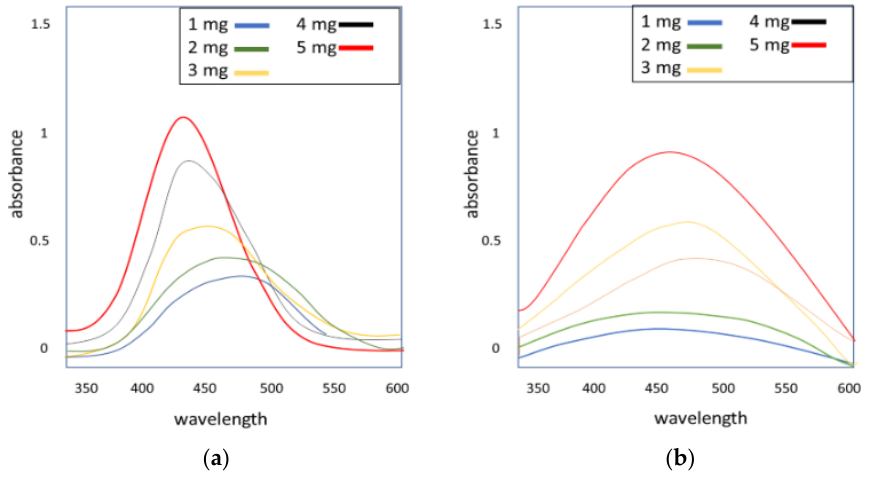
Figure 1. Effect of extract concentration on the preparation of SNPs ( a ) for TSADE and ( b ) for